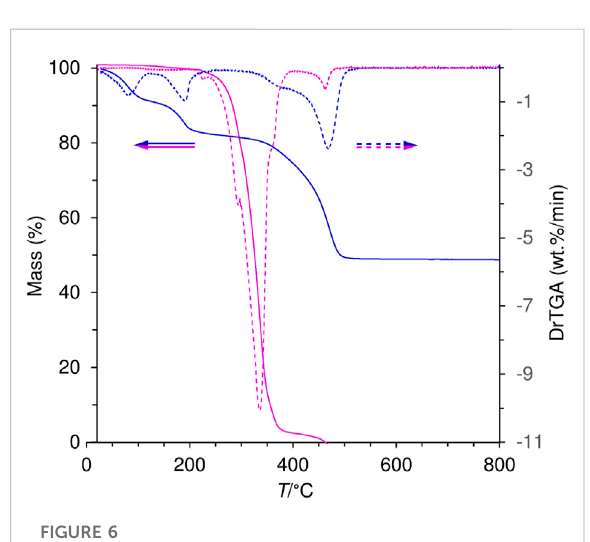
FIGURE 6 TGA (solid lines) and corresponding DTG (dashed lines) curves for the ketodiacid 3 (magenta) and LDH-KDA3